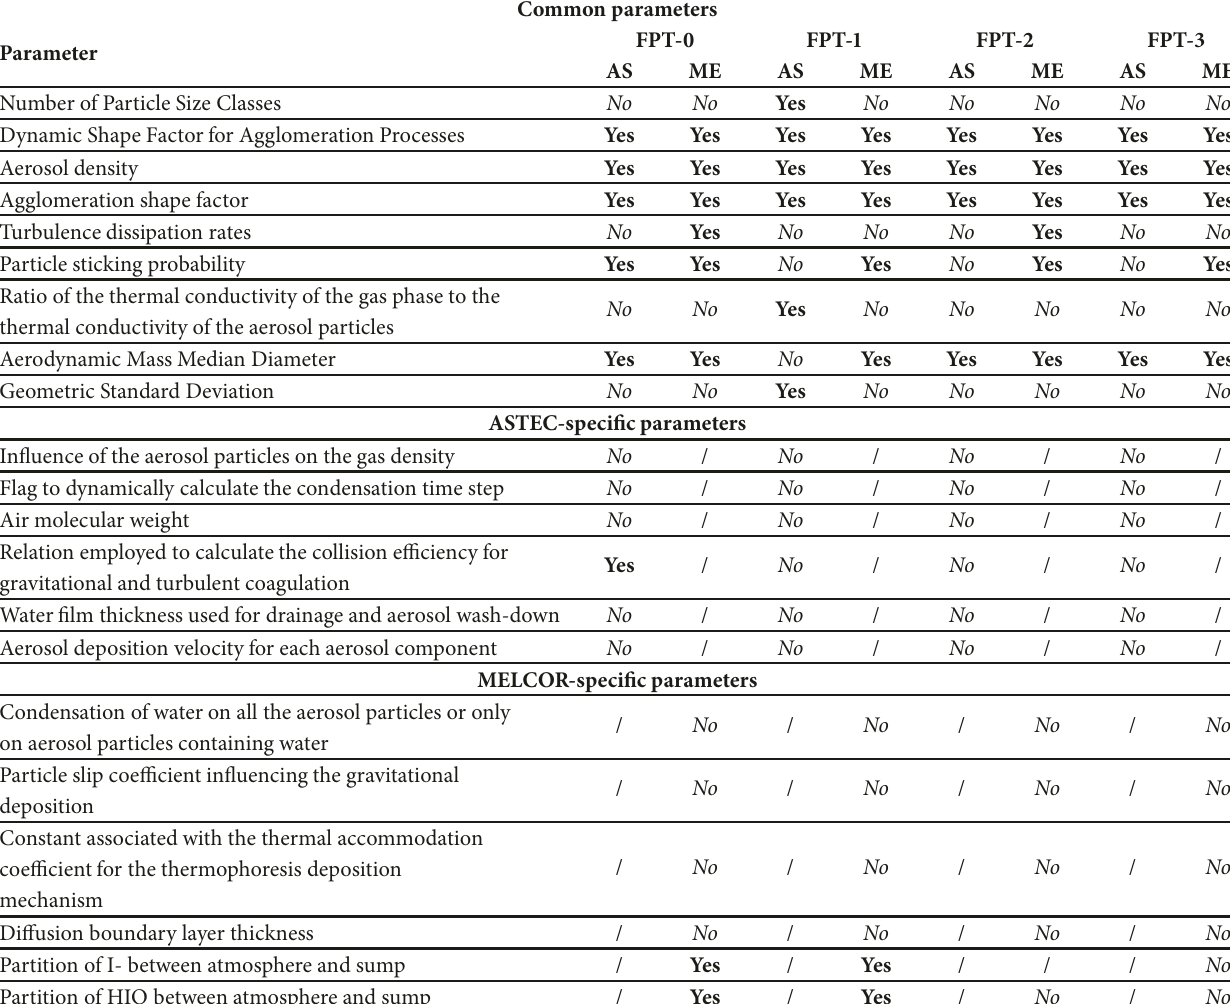
Table 6: Summary of the investigated parameters and influence for each Ph´ebus test. Common